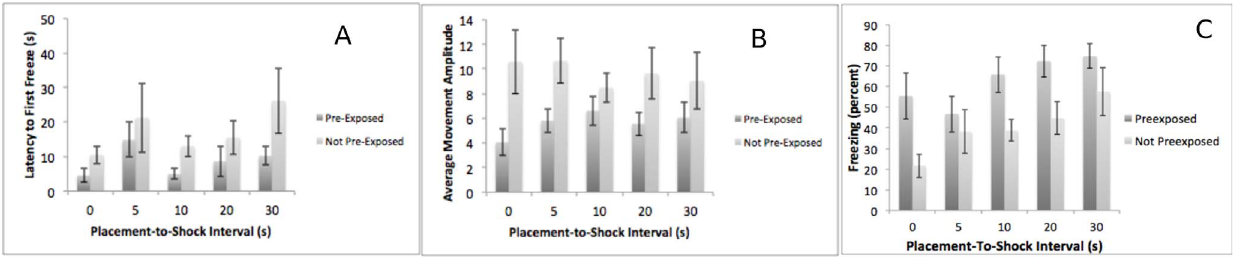
Figure 2. The results of Experiment 1–2 – contextual fear conditioning at PD 24/25/26. Subjects pre-exposed (dark bars) or not pre- exposed (light bars) to the conditioning context on day 1 significantly differ in their latency to freeze (Panel A), their initial movement amplitude (Panel B) and their freezing (Panel C) on test day.